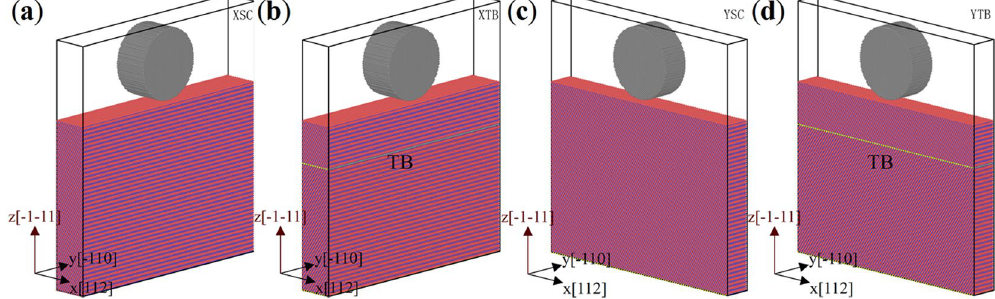
Figure 1. Atomic models for MD simulation of indentation. ( a ) XSC; ( b ) XTB; ( c ) YSC; ( d ) YTB. Red, blue and grey balls represent V, N and C atoms, respectively. Yellow atomic layer represents the twin boundary (TB).